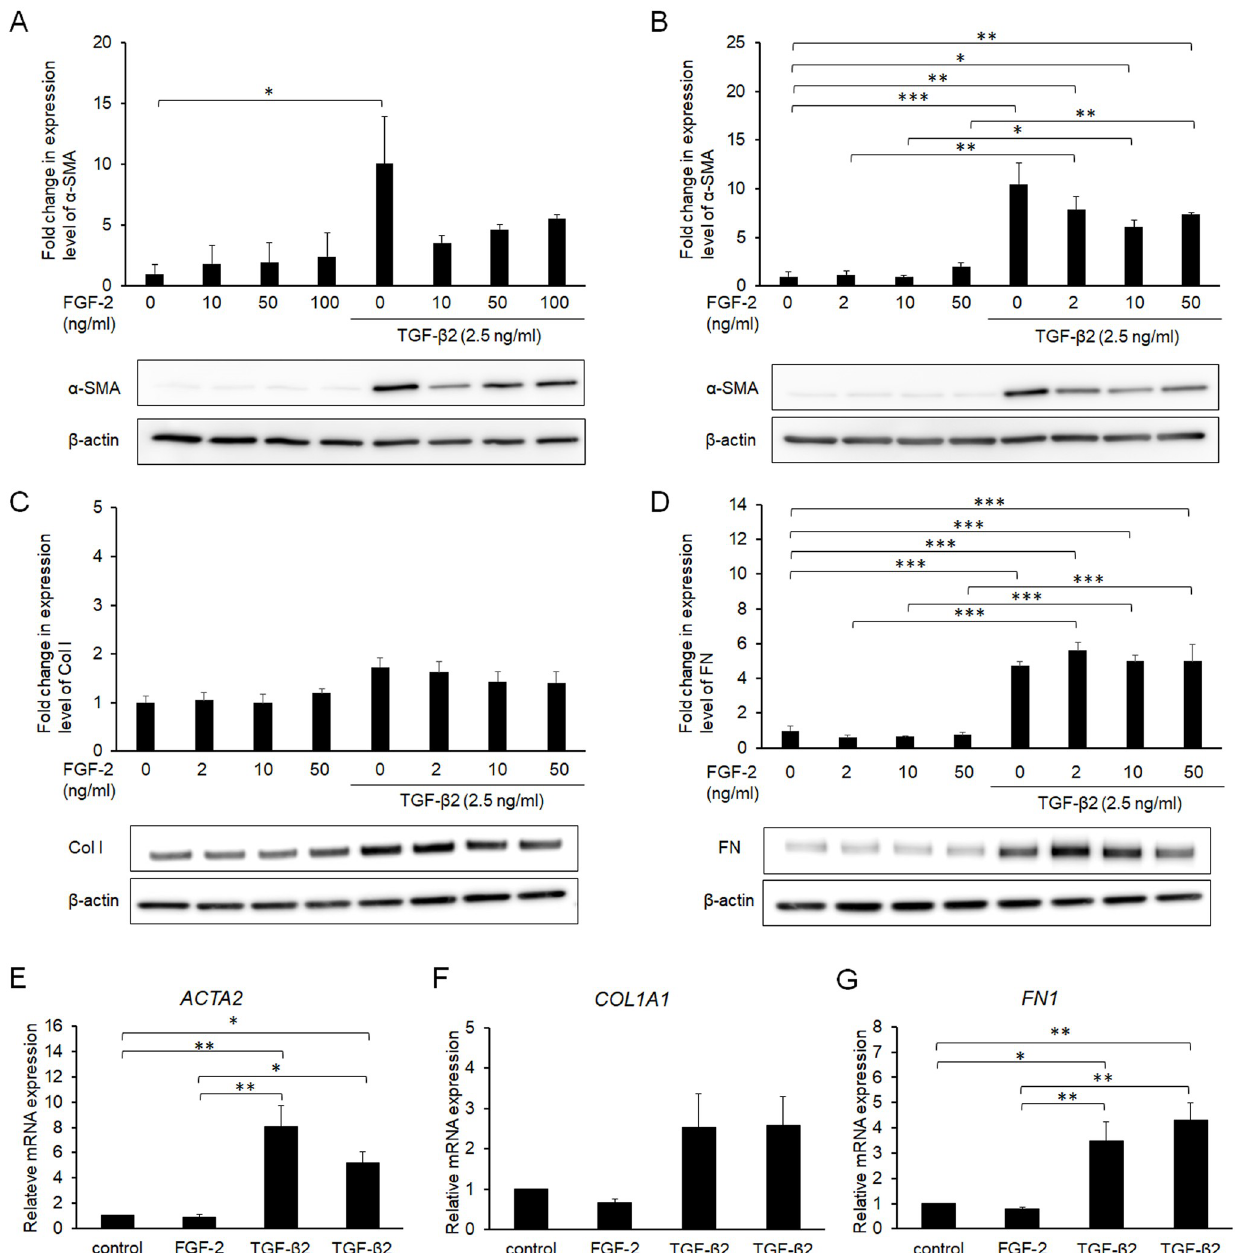
Fig 1. Effects of fibroblast growth factor (FGF)-2 on α -smooth muscle actin (SMA), collagen type I (Col I), and fibronectin (FN). Conjunctival fibroblasts were treated with FGF-2 (0–100 ng/mL) in the presence or absence of 2.5 ng/mL transforming growth factor (TGF)- β 2 for 48 h, and subjected to Western blot analysis (A-D) or quantitative RT-PCR analysis (E-G). In the protein level, FGF-2 suppressed the TGF- β -induced expression of α -SMA (A, B) and Col I (C), but not FN (D). In the mRNA level, FGF-2 suppressed expression of only ACTA2 coding α -SMA (E-G). Data are shown as the mean ± SE, n =